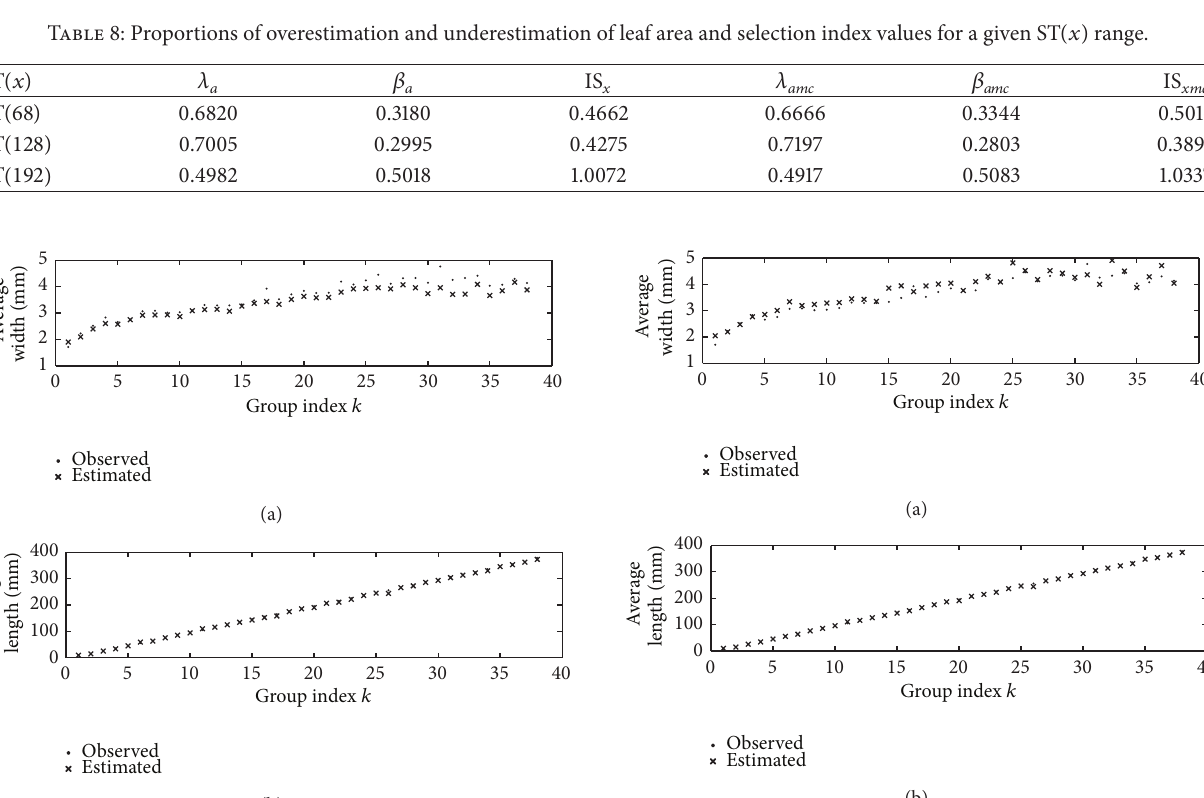
𝑘 𝑜 and image estimated 𝐺 (𝑙) . (b) Comparison of 𝑘 𝑙 𝑘 𝑑 length averages taken over